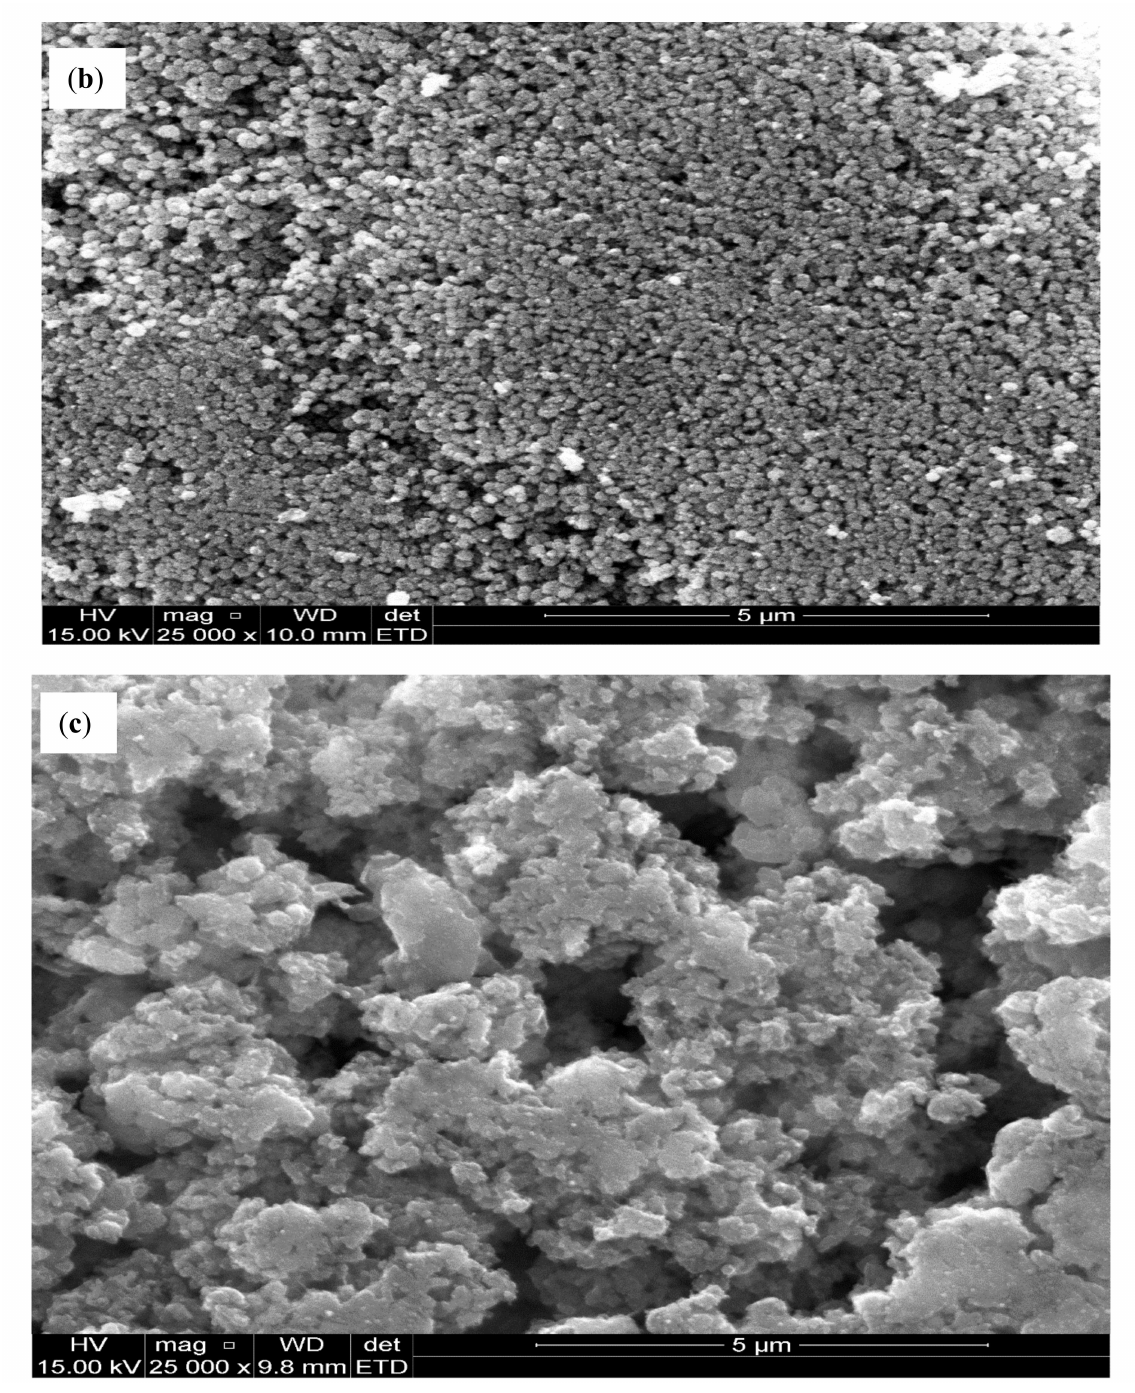
Figure 4. The SEM images of ( a ) LPE/BiONPs ( b ) OPE/BiONPs, ( c ), PANI. Figure 4 represents the surface morphology of the chemically prepared PANI, which indicated that the PANI has a coarse surface, which is similar to earlier literature re- ports [68,69]. The microstructure morphology of the PANI is considered as being of a positive effect on its particle specific surface area and the counter anions diffusion [68]; hence, it is profitable for the amplification of specific capacitance of PANI electrode. On the other hand, the rough surface may influence negatively the PANI’s conductivity